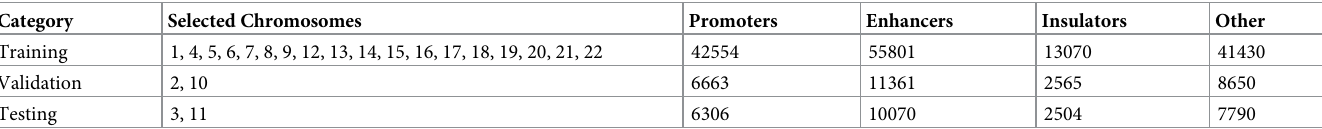
Table 2. Chromosomes & number of examples for training, validation, and test